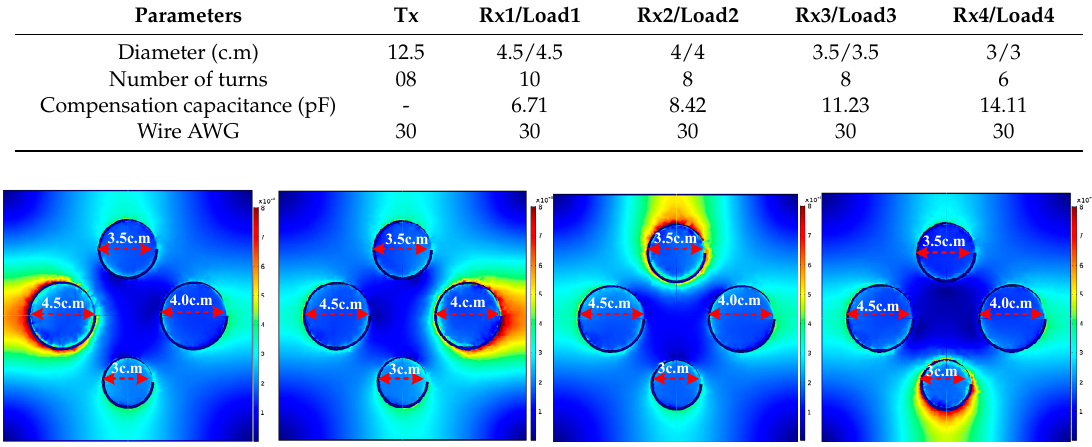
Table 4. Design parameters of coil.